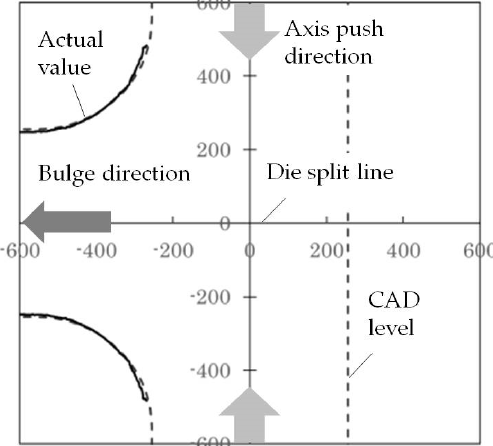
Figure 4. Design profile (dotted line) and measured profile (solid line) nearby die shoulder part for